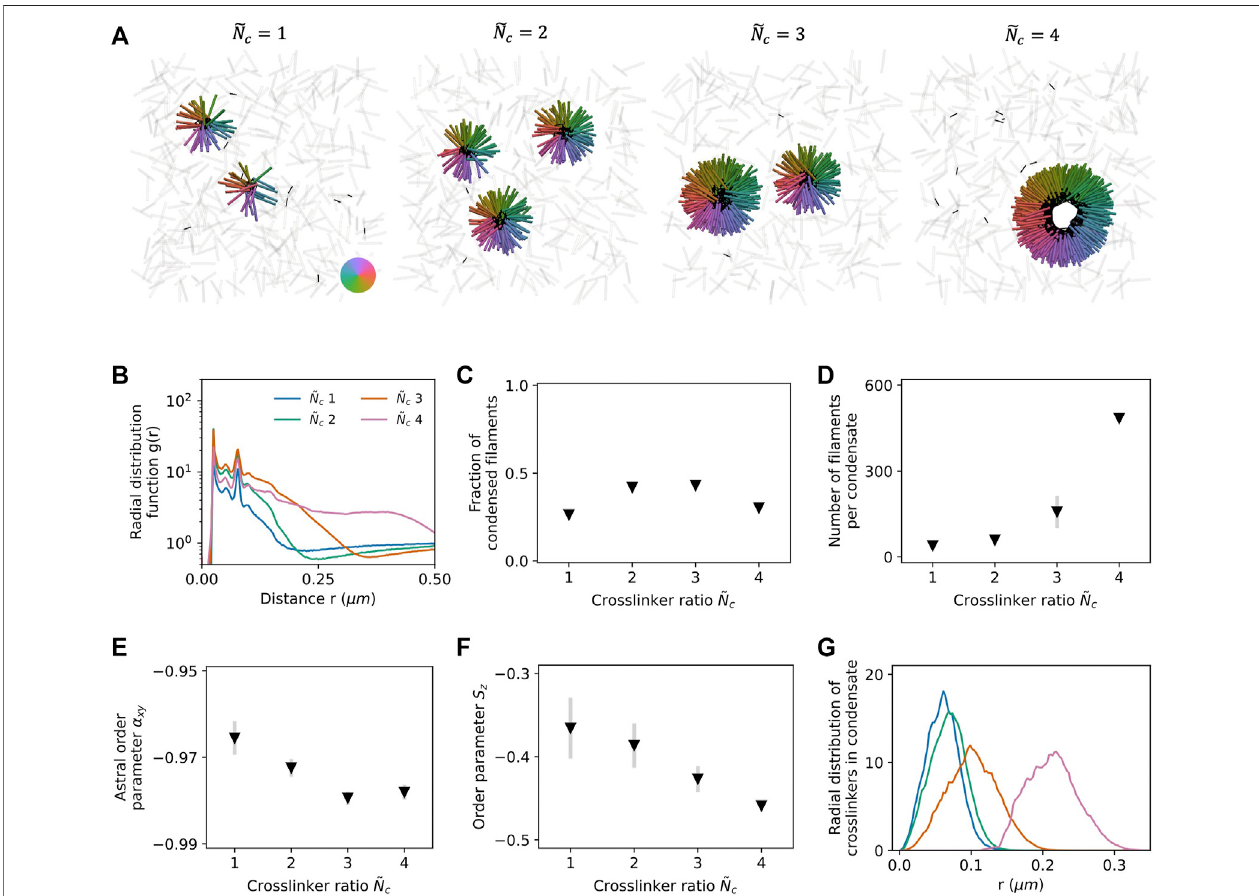
FIGURE 3 | Filaments and end-pausing crosslinking motor proteins self-assemble into fl ower-like and ring-like asters when con fi ned between two planar surfaces with separation H = L . (A) Simulation snapshots for varying crosslinker number ratio ~ N c (cid:2) N c / N . End-pausing crosslinking motors (black) bind and walk on fi laments (coloredaccordingtotheir XY orientation),beforepausing atthe fi lament plusend.Condensate morphologychangesfrom fl ower-like ( ~ N c (cid:2) 1 , 2 , 3 ) toring-like ( ~ N c (cid:2) 4 ) . (B) Radial distribution function g ( r ) computed for fi lament plus ends. The fi rst peak at 25 nm, equal to the fi lament diameter, is due to steric exclusion between fi lamentpairs. Asecondpeak at 78 nm,the sum of fi lamentdiameter and crosslinking motor restlength, arisesfrom crosslinked fi lamentpairs. As ~ N c increases, thesize of the condensate increases, as evidenced by a widening of g ( r ). (C) Fraction of condensed fi laments increases to 0.45, before decreasing to 0.3 for ~ N c (cid:2) 4. This dip in condensedfraction isdue tothe presence ofasingle aster, asopposed tomultiple. (D) As ~ N c increases,thenumber of fi laments per condensate increases non-linearly. This is determined by the number of crosslinking motors per condensate. (E) The astral order parameter α xy is negative for all condensates, indicating that the fi lament orientations in the XY plane tend to point toward the center of the condensate. The increase in the absolute value of α xy with increasing ~ N c is evidence for an increase in radial symmetry. (F) Scalar order parameter S z of the condensed fi laments decreases with increasing ~ N c , indicating an increase in alignment in the XY plane. (G) Radial distribution of crosslinking motors, measured relative to the center of the condensate. With increasing ~ N c , the crosslinker core widens and becomes hollow for ~ N c (cid:2) 4. Note: C-F show mean values averaged over 10 s of a single simulation and error bars show standard deviation. Where not visible, errors are too small.